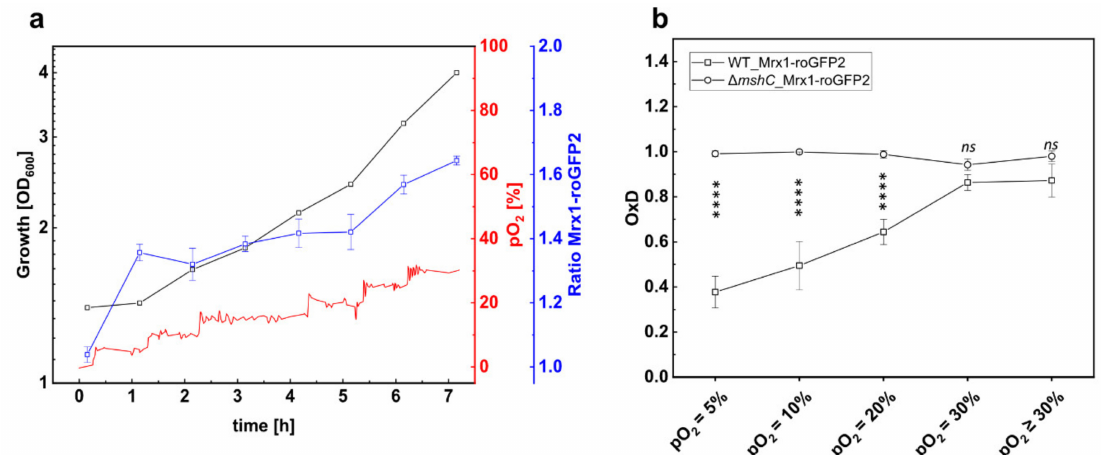
Figure 3. Growth and 380 / 470 nm excitation ratio of the Mrx1-roGFP2 biosensor of C. glutamicum WT_Mrx1-roGFP2 (WT_Mrx1-roGFP2) during batch cultivation in stirred bioreactors ( a ) and calculated oxidation degree (OxD) at di ff erent pO 2 levels during batch fermentation conducted with WT_Mrx1-roGFP2 and the MSH-deficient mutant strain C. glutamicum ∆ mshC _Mrx1-roGFP2 ( ∆ mshC _Mrx1-roGFP2) ( b ). Fermentation was performed in BIOSTAT ® B bioreactors using CGXII minimal medium (T = 30 ◦ C, pH = 7.0; initial glucose concentration 20 g L − 1 ). OxD values at